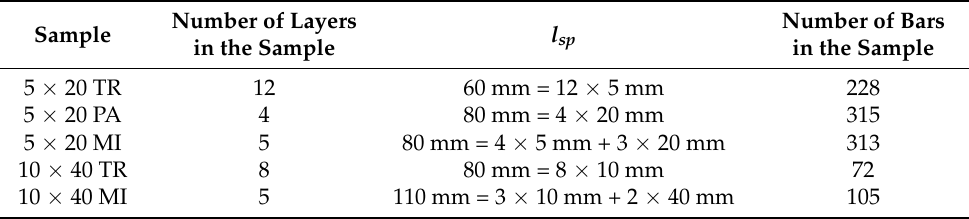
Table 1. The values of l sp and number of layers and number of bars for individual samples. Number of Layers Sample